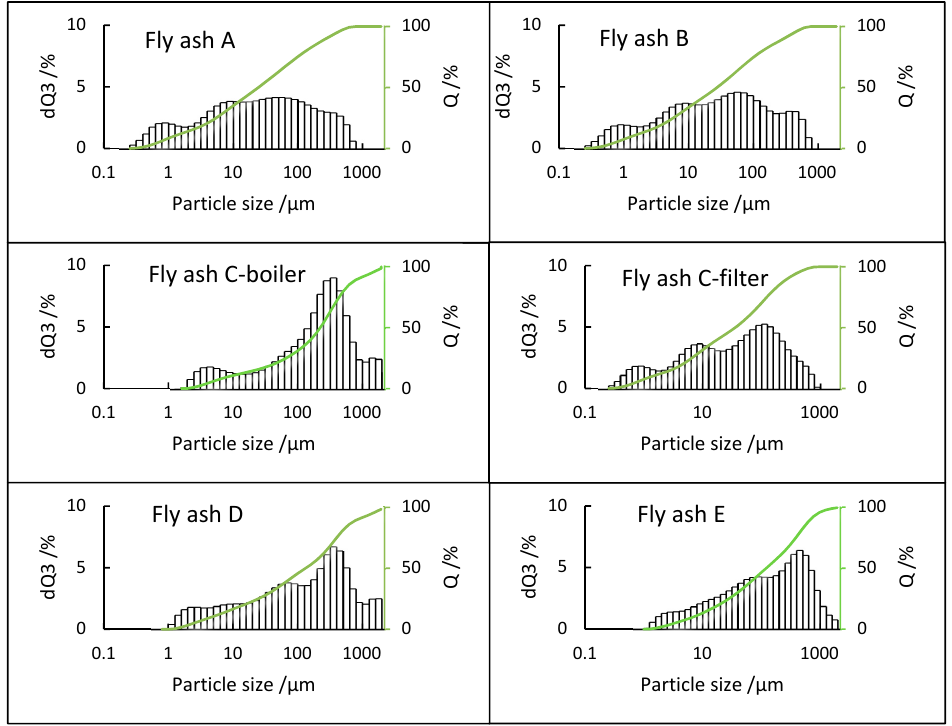
Figure 4. PSDs of all fly ash samples, dQ3 (volume %), and Q (cumulative distribution %).